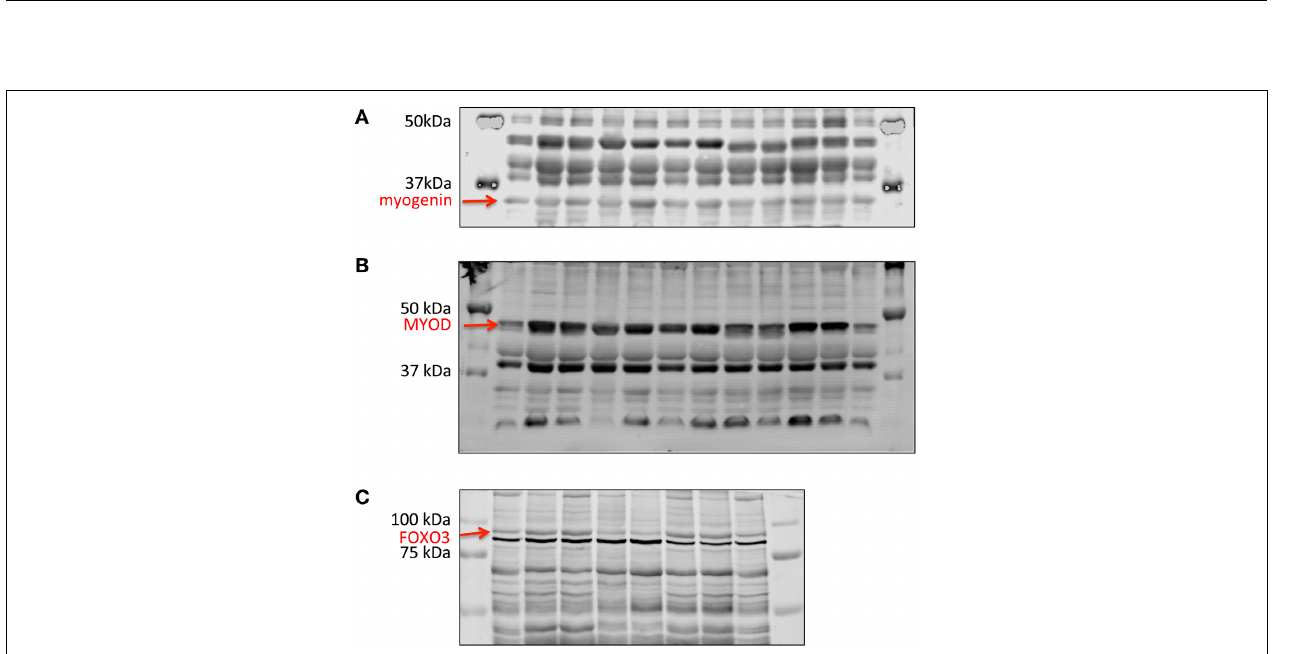
FIGURE A2 | Representative western blots for the proteins myogenin (A), MYOD (B), and FOXO3 (C).